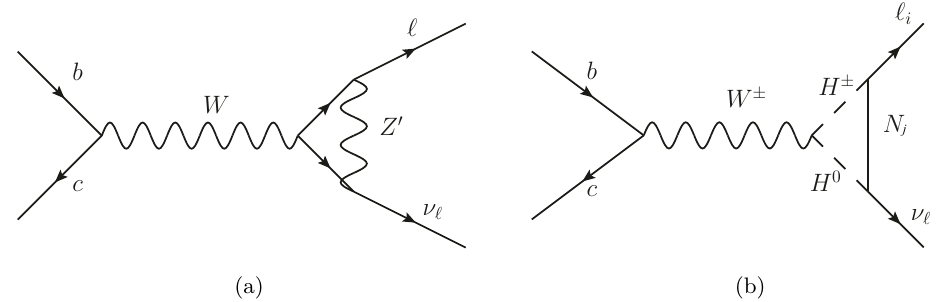
Figure 10 . Diagrams contributing to flavour changing charge current process b → c‘ ¯ ν ‘